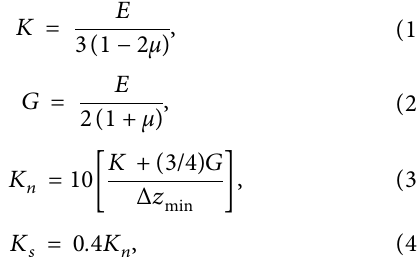
Convergence curve of measurement point A at 615m section Convergence curve of measurement point B at 615m section Convergence curve of measurement point C at 615m section